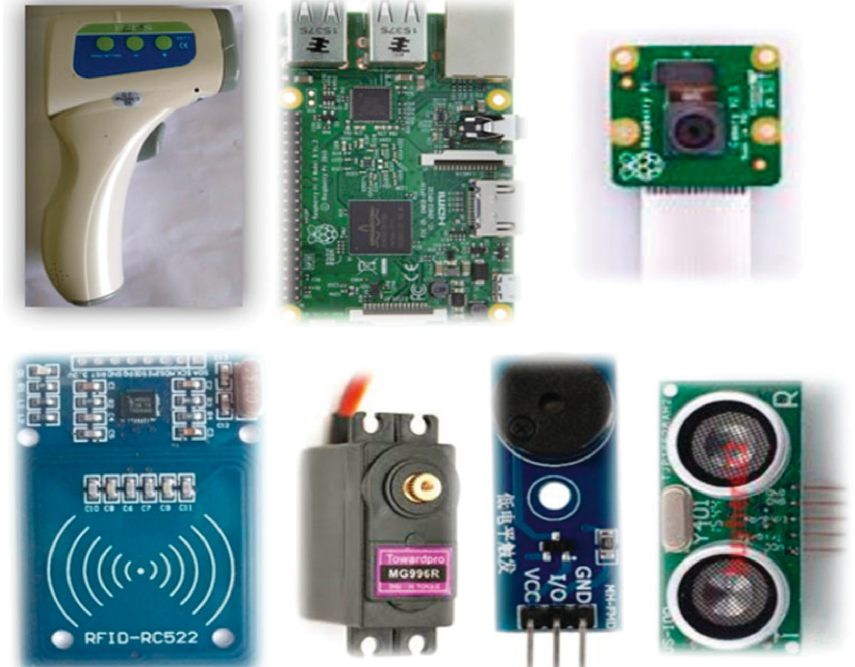
Figure 2: Components of the autothermometer system (from top left): a forehead thermometer, a Raspberry Pi device, a camera module, an RFID reader, a servo motor, a buzzer, and an ultrasonic